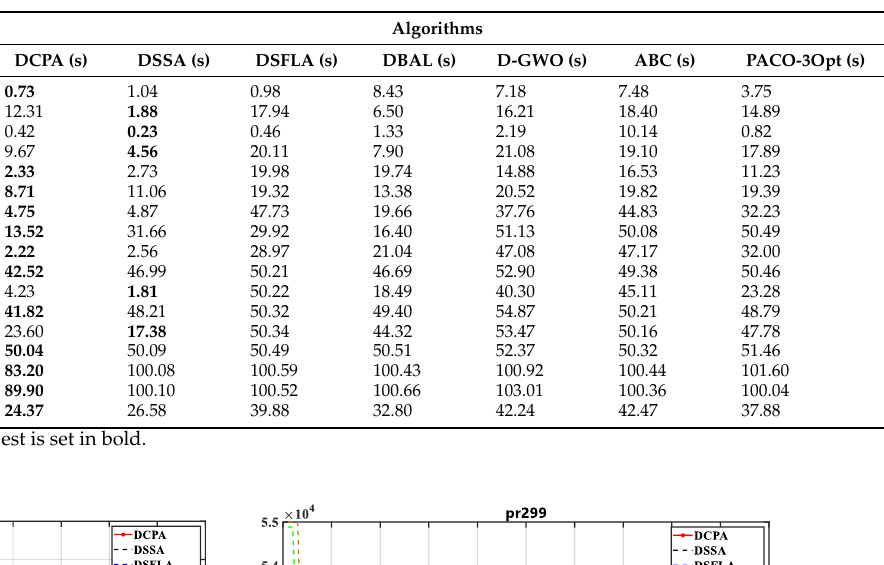
Table 18. The computation times of the participating algorithms with city sizes less than 250.